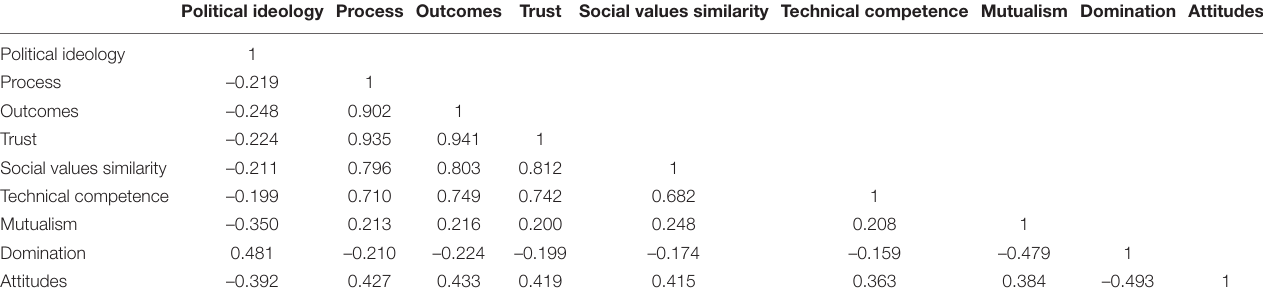
TABLE 4 | Bivariate correlations among political orientation, wildlife value orientations, and trust in the state wildlife management agency for wolf stakeholders in Minnesota, United States. Political ideology Process Outcomes Trust Social values similarity Technical competence Mutualism Domination